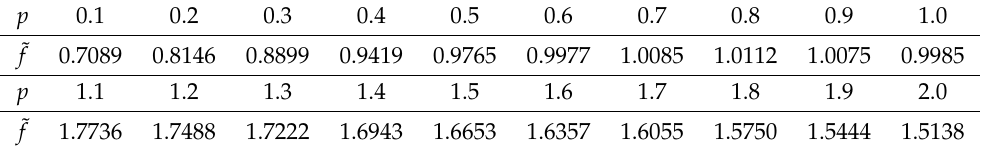
(cid:12) (cid:12) (cid:12) ˜ f − f (cid:12) between two formulas with different p